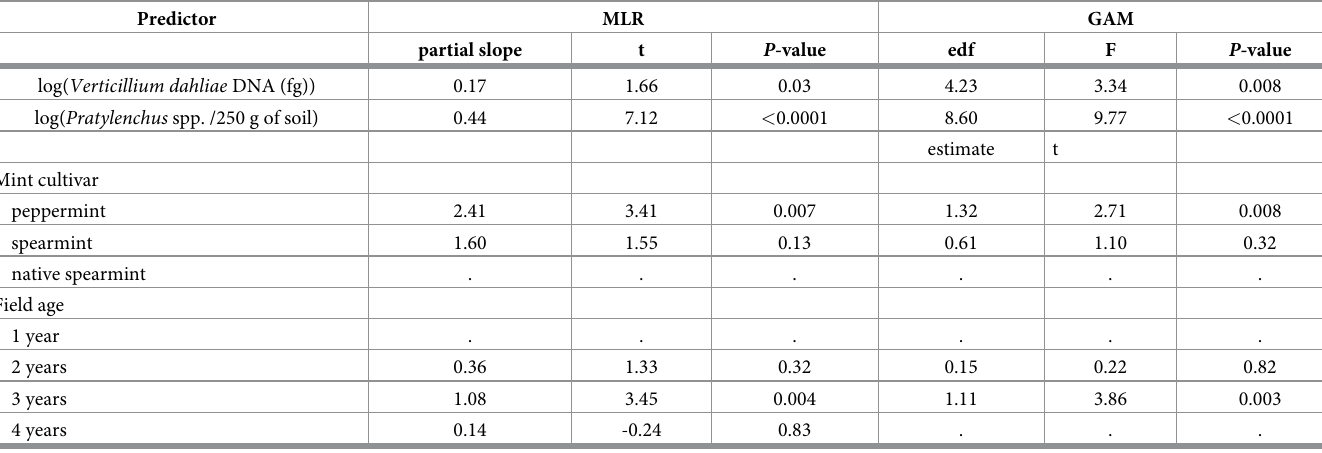
Table 1. Effects of predictors on wilt symptoms from the two statistical models. Predictor